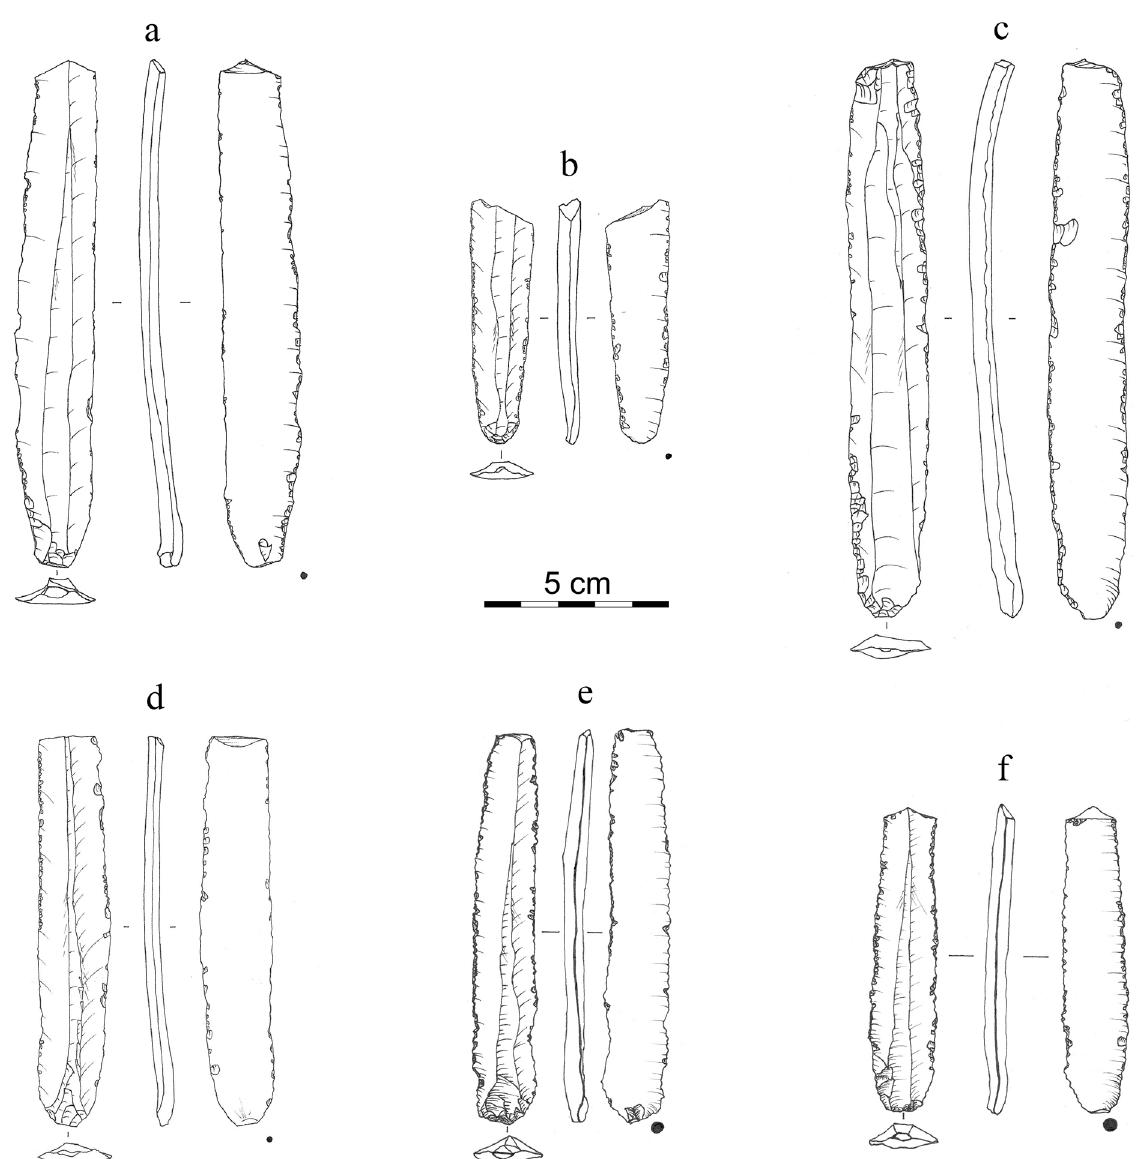
Figure 2. Tronçons de lames d’Aknashen fabriqués par pression debout à la béquille. Figure 2. Segments of blades from Aknashen knapped by standing up pressure with a